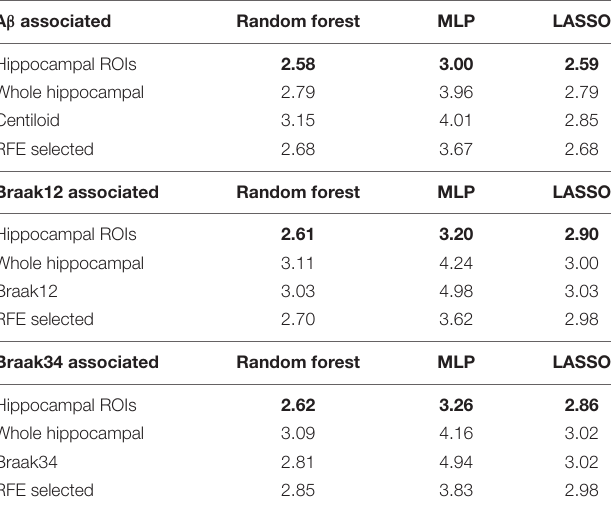
TABLE 2 | Root mean squared errors for predicting MMSE based on various kinds of biomarkers and